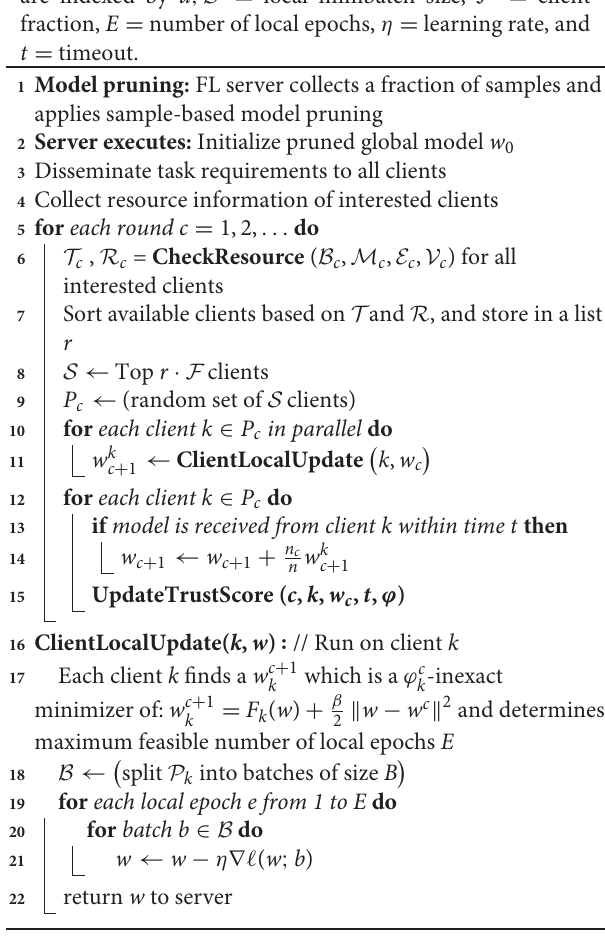
Algorithm 2: FedPARL Framework. The S eligible